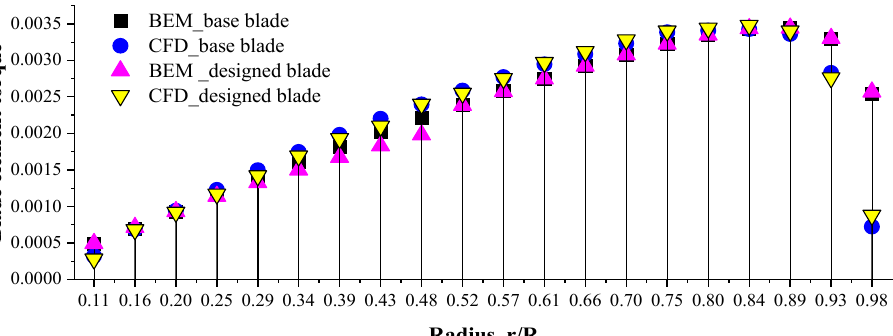
Figure 16. The generated aerodynamic torque along the blade during power generation.